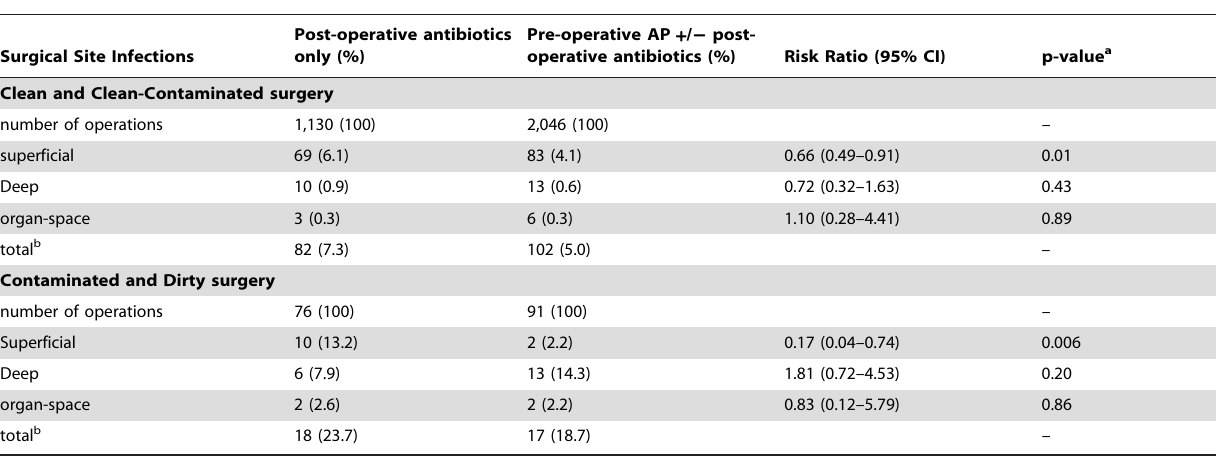
Table 2. Overall risk of SSI with and without use of pre-operative antibiotic prophylaxis.